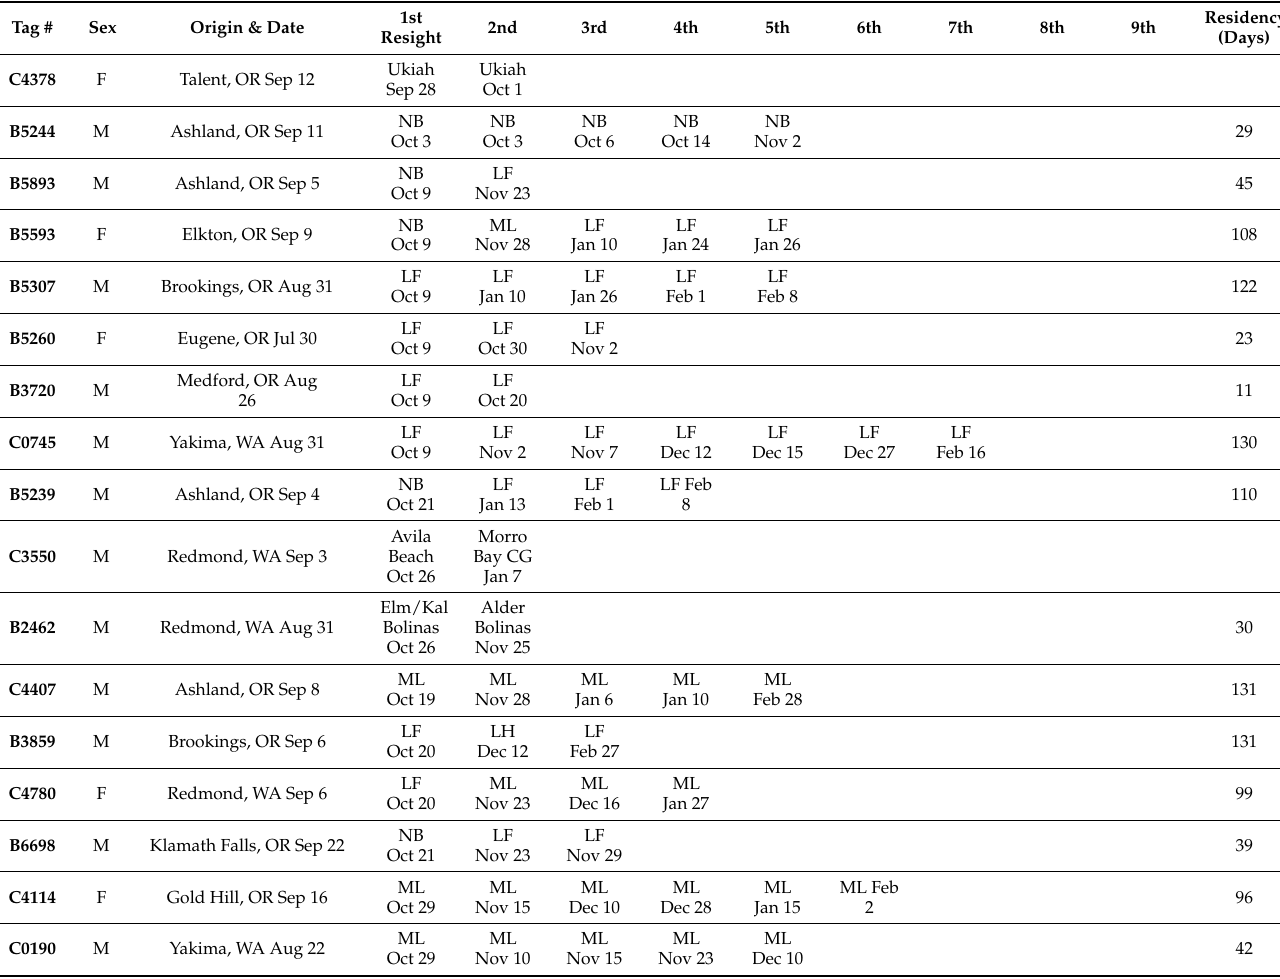
Table 5. Re-sighting data for captive-reared tagged monarchs in California in 2017. All data from overwintering sites except for C4378 re-sighted during migration. Santa Cruz overwintering sites: NB = Natural Bridges State Beach, LF = Lighthouse Field State Beach, ML = Moran Lake. Residency = period spent at overwintering site